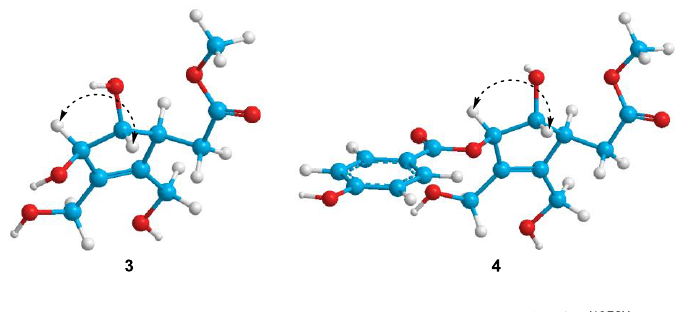
Figure 3. The key NOESY correlation of compounds 3 and 4 .